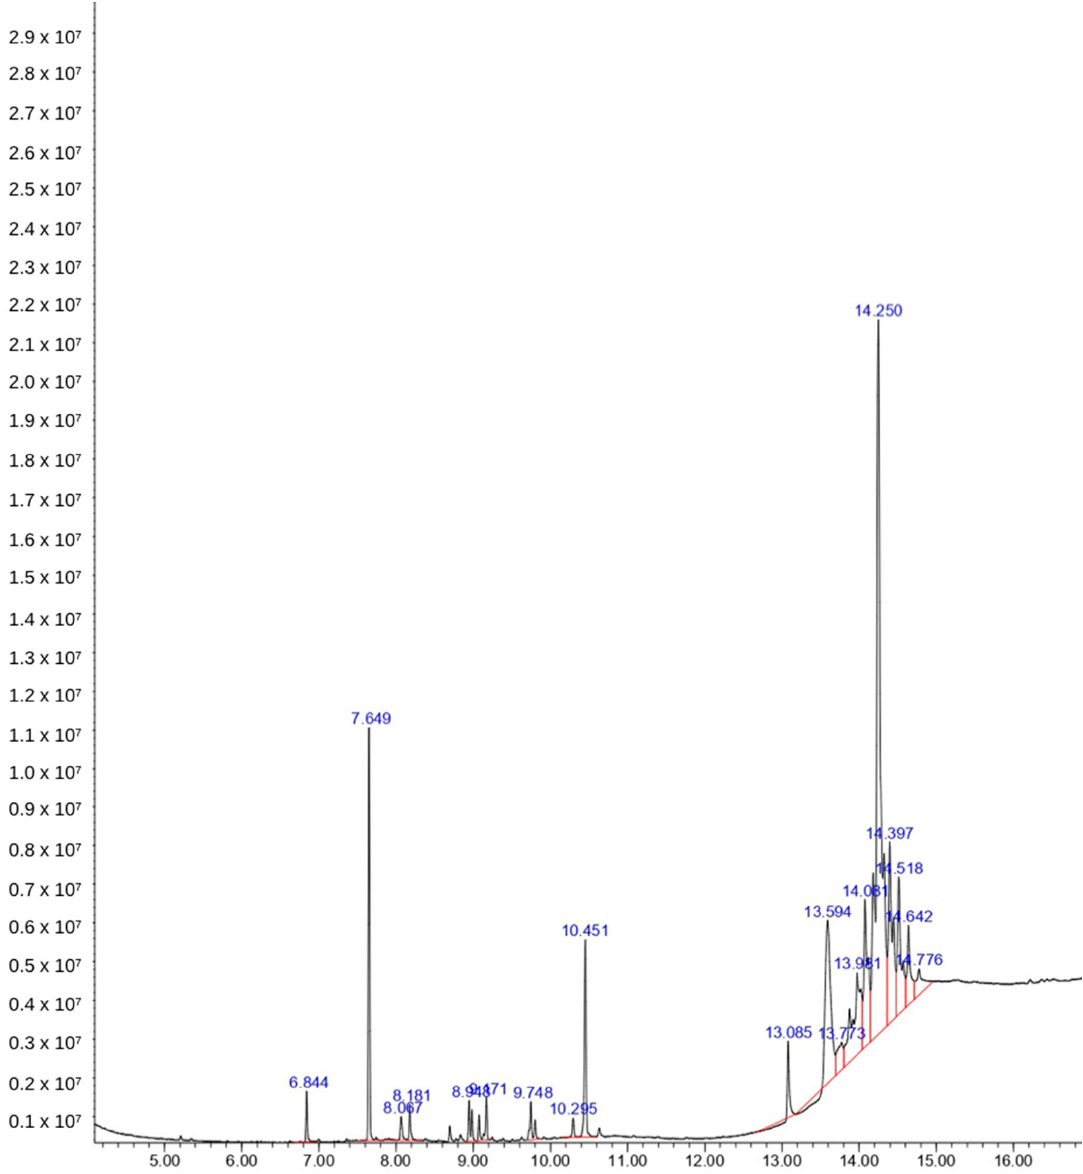
Figure 2. Chromatogram of Bulung Boni ethanol extract. The largest AUC showed in 14.250 of re- tention time, indicating that Cyclohexanamine is the dominant chemical of Bulung Boni.